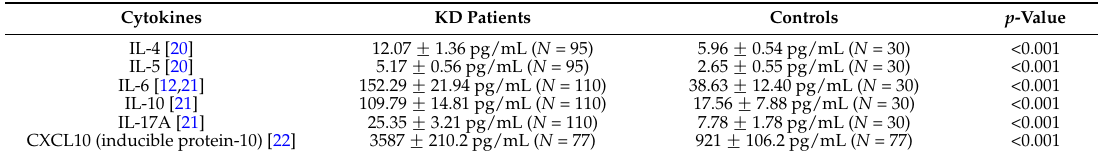
Table 1. Cytokines expression between Kawasaki disease (KD) patients and controls. Cytokines KD Patients